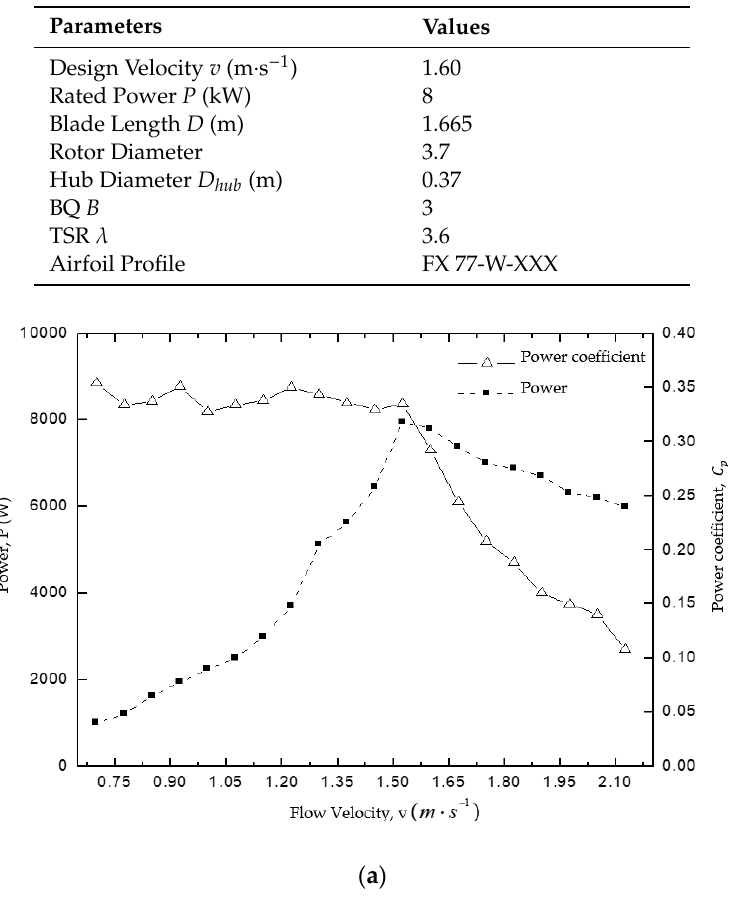
Table 2. The overall design parameters of the blade.